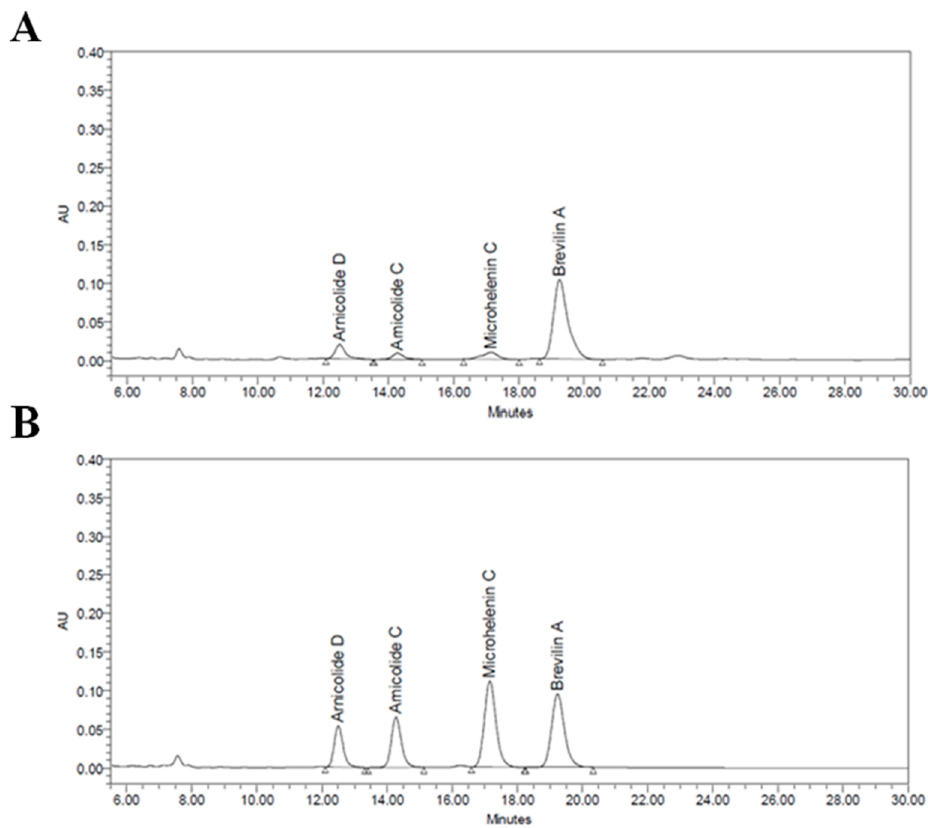
Figure 2. HPLC chromatogram of CMX. ( A ) HPLC chromatogram of CMX sample. ( B ) HPLC chro- matogram of standard mixtures of Aricolide D, Arnicolide C, Microhelenin C, and Brevilin A. CMX, emulsion extract from Centipeda minima; HPLC, high-performance liquid chromatography. The column temperature was maintained at 40 °C and the wavelength was set at 224 nm.